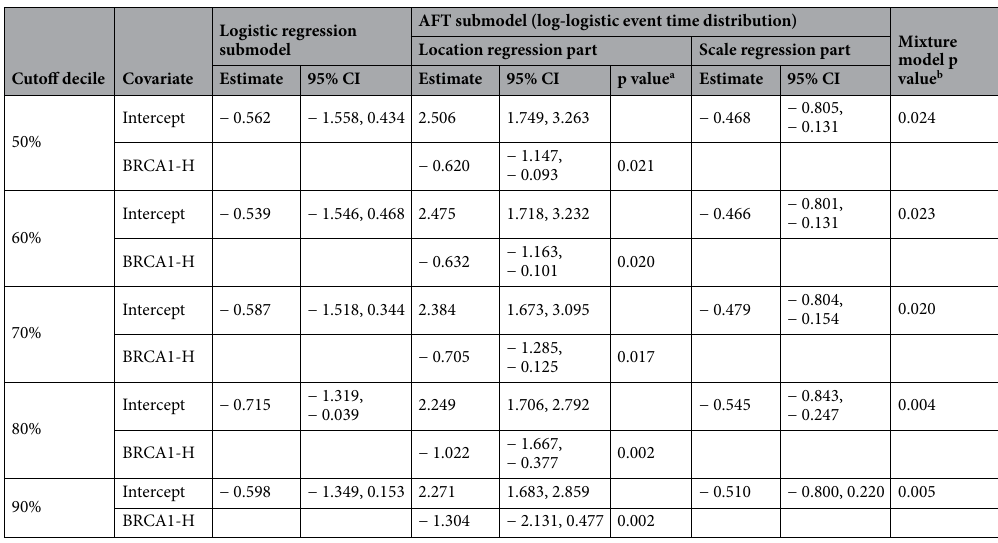
Table 1. Analysis of the log-logistic-AFT mixture regression model stratified by BRCA1-level with different cutoff points. CI, confidence interval; BRCA1-H, high BRCA1; LRT, likelihood ratio test. p value a of Wald’s statistic for testing the location parameter corresponding to BRCA1-H. p value b of the LRT for testing the significance of the fitted mixture